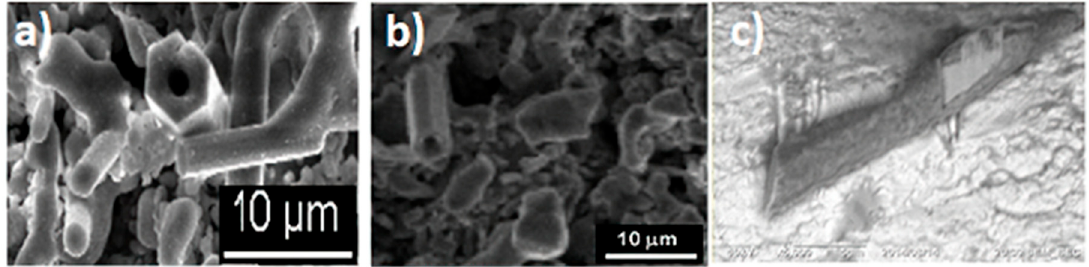
Figure 7. ( a ) Fe 2 Ti microtubes with a width of 2 μ m and intermetallic microtubes with a width of 5 μ m in the AlTi 3 system, ( b ) AlTi 3 microtubes with a width of 3 μ m and ( c ) longitudinal cut of the rod in the AlTi 3 system, ( b ) AlTi 3 microtubes with a width of 3 µ m and ( c ) longitudinal cut of the rod that that has two phases. has two